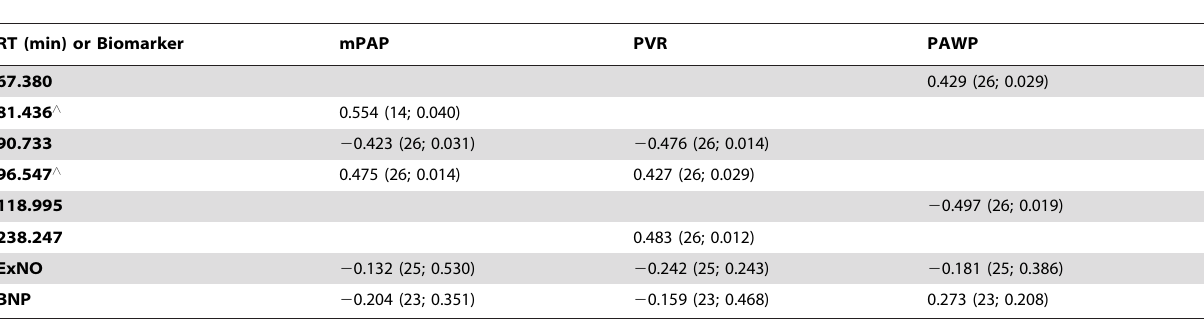
Table 4. Correlations with pulmonary hemodynamic